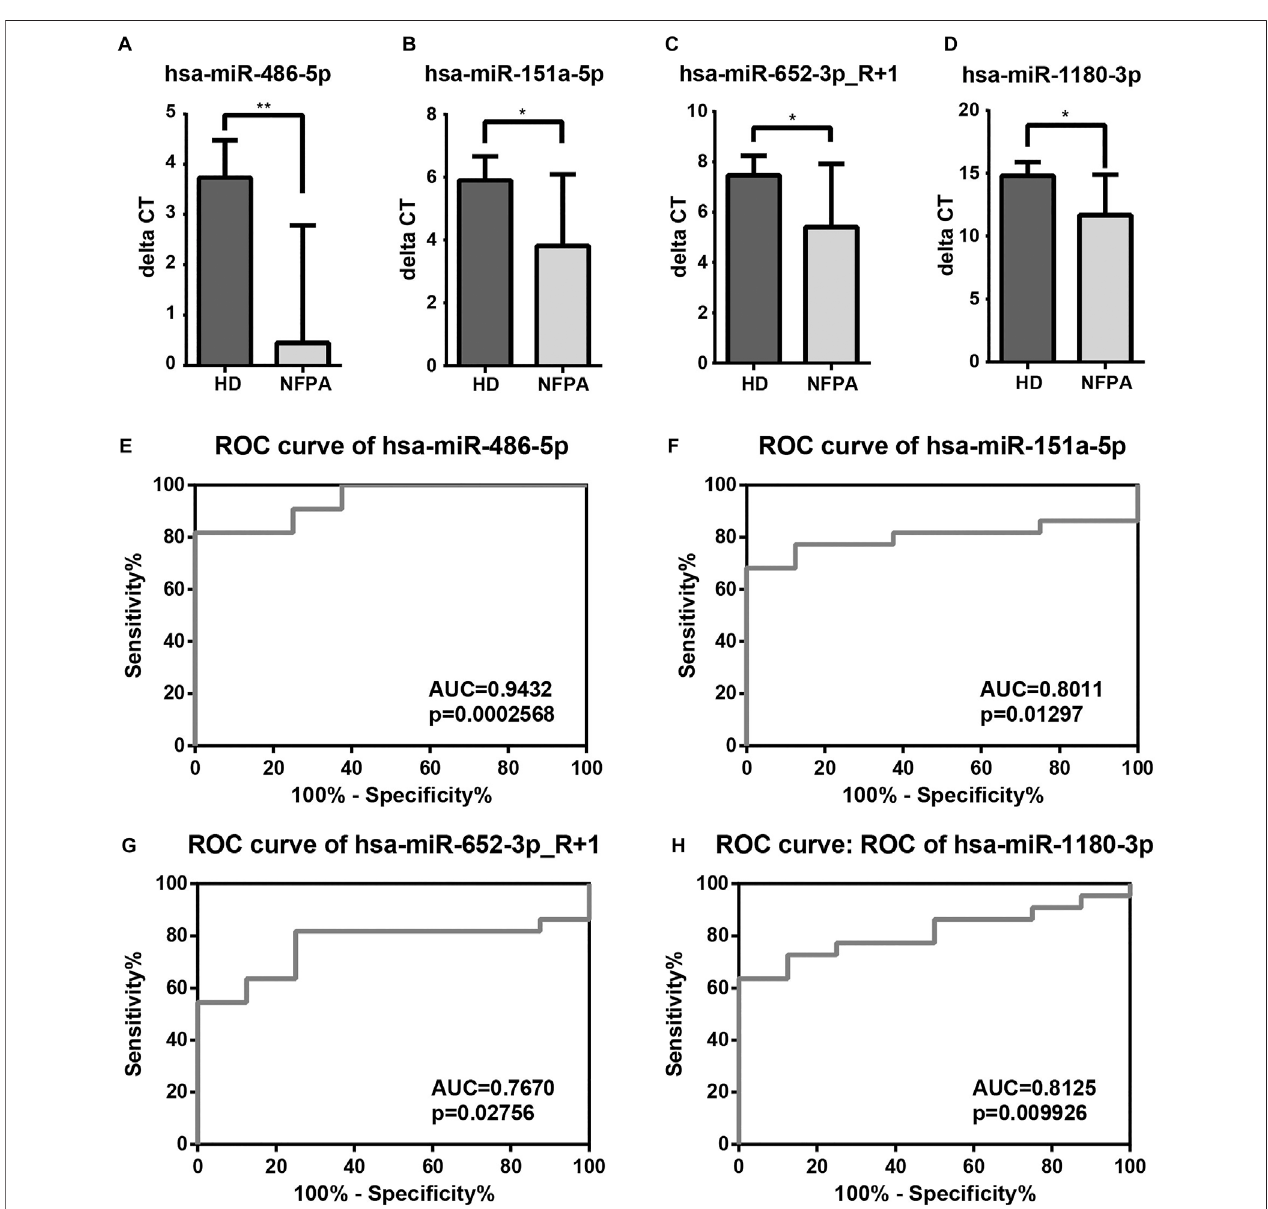
FIGURE 4 | Validation and diagnostic performance of DE-miRNAs. (A – D) Among 13 selected DE-miRNAs, hsa-miR-486-5p, hsa-miR-151a-5p, hsa-miR-652- 3p_R+1,andhsa-miR-1180-3pwereup-regulatedinNFPAs. (E – H) ROCcurvesrevealedthathsa-miR-486-5pwasthemostcompetentbiomarkerforNFPAscreening than hsa-miR-151a-5p, hsa-miR-652-3p_R+1, and hsa-miR-1180-3p.